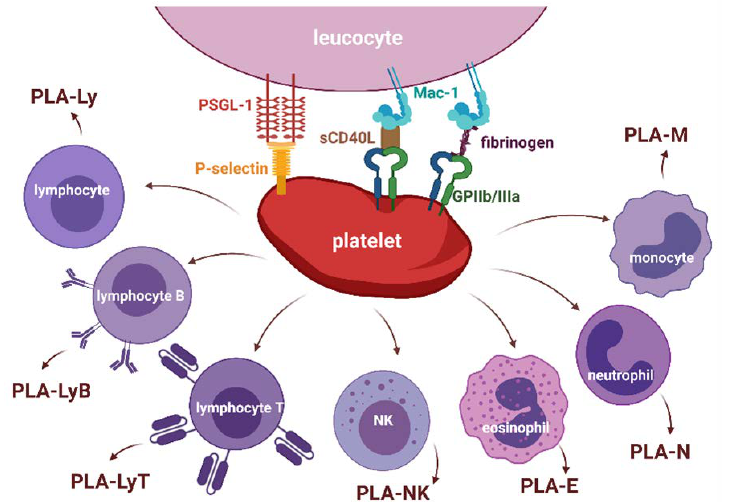
Figure 1. Molecules tethering platelets with leucocytes in platelet–leucocyte aggregates and sub- sets of platelet–leucocyte aggregates. Abbreviations: GP IIb/IIIa—glycoprotein IIb/IIIa; Mac-1— complement receptor 3; PLA-E—platelet-eosinophil aggregates; PLA-Ly—platelet–lymphocyte aggre- gates; PLA-LyB—platelet–lymphocyte B aggregates; PLA-LyT—platelet–lymphocyte T